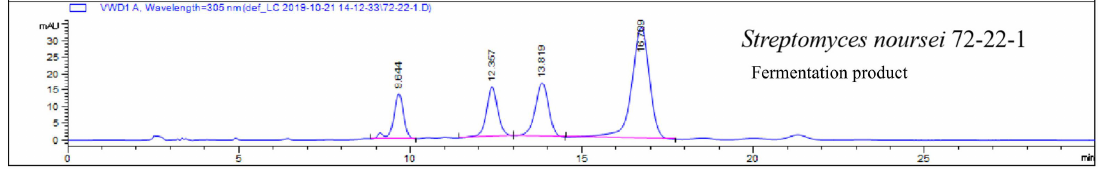
Figure 6. HPLC analysis of the fermentation products of Streptomyces noursei 72-22-1. It can be seen that in the mutant Streptomyces noursei 72-22-1, nystatin A1, A3, and polyfungin B exhibited retention times of 9.085 min, 12.288 min, and 16.599 min. The ratio of polyfungin B was about 53%, which is much higher than the Table 6. Results of nystatin A1, A3, and polyfungin B inhibiting Saccharomyces cerevisiae ATCC 2061. Expt. No.